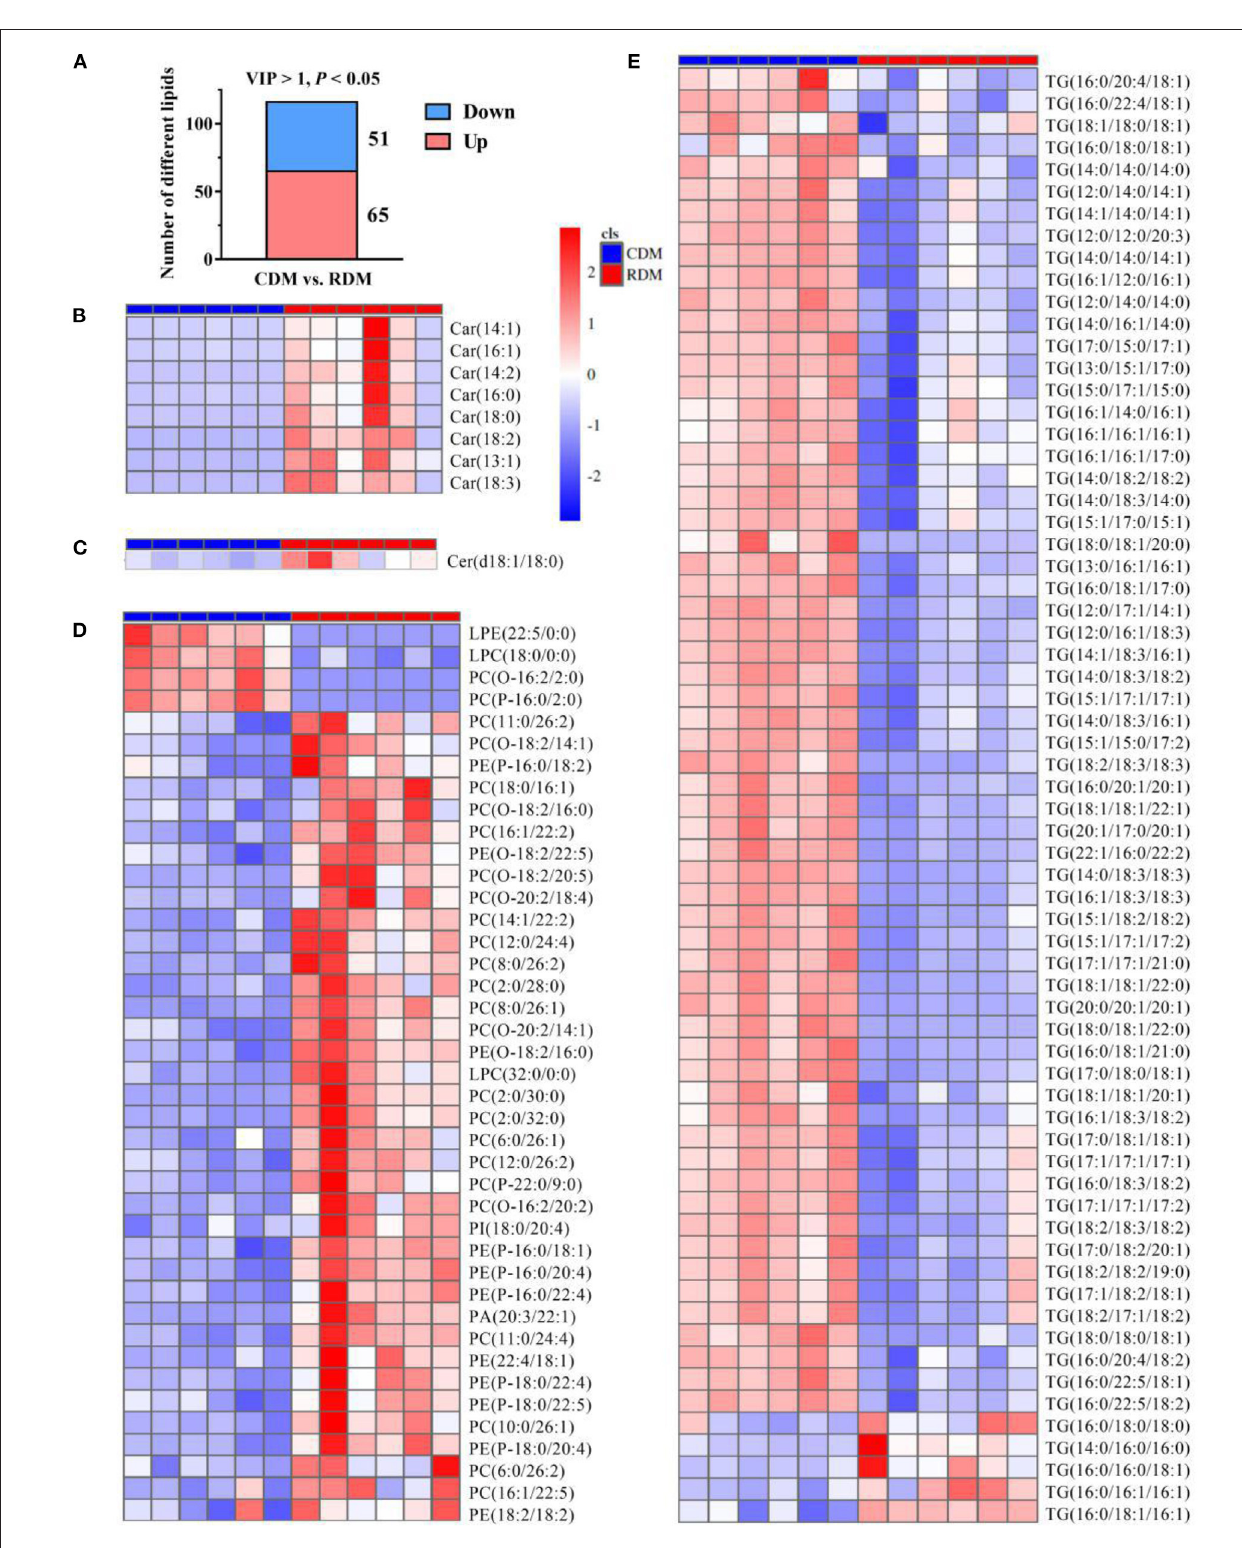
Frontiers in Nutrition |